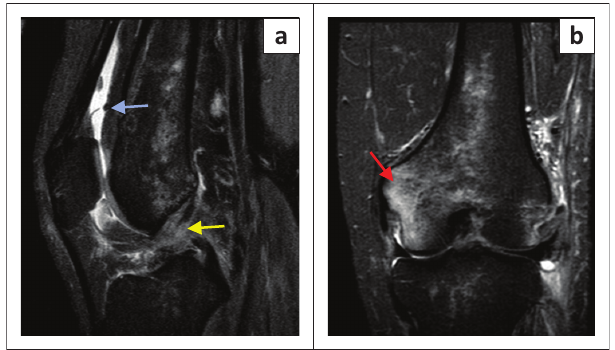
FIGURE 8: Images from a true positive anterior cruciate ligament tear: (a) sagittal view and (b) coronal view.